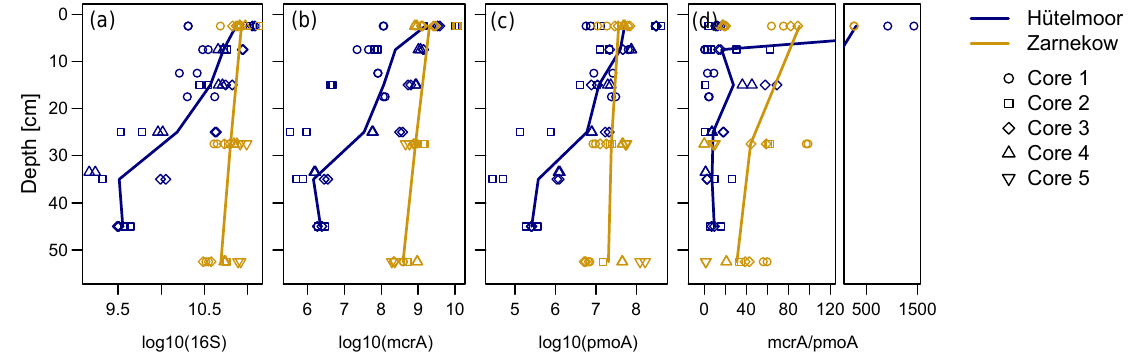
Figure 7. Depth distribution of qPCR abundances for total microbial (16S), methanogen ( mcrA ), methanotroph ( pmoA ), and ratio of mcrA to pmoA gene copy numbers in both sites. Microbial abundances were designated as numbers of gene copies per gram of dry peat soil. Duplicate measurements per depth section are shown against sampling depth using log-transformed values. Solid lines indicate mean abundances for individual wetlands ( n = 4 for Hütelmoor and n = 5 for Zarnekow). Note that the plot at the right was split into two plots to capture very high mcrA / pmoA ratios in the upper peat